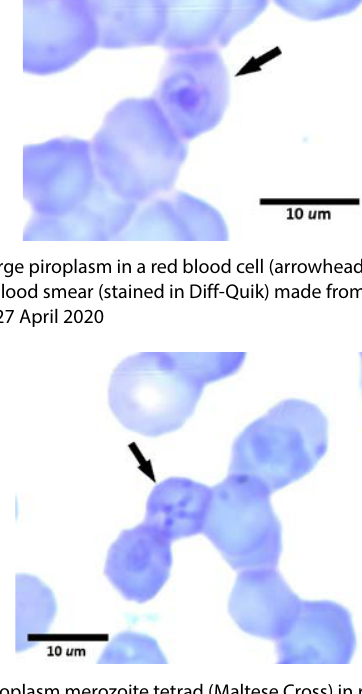
Figure 3: Piroplasm merozoite tetrad (Maltese Cross) in red blood cell (arrowhead) of the peripheral blood smear (stained in Diff-Quik) made from the black rhino Akhona on 27 April 2020